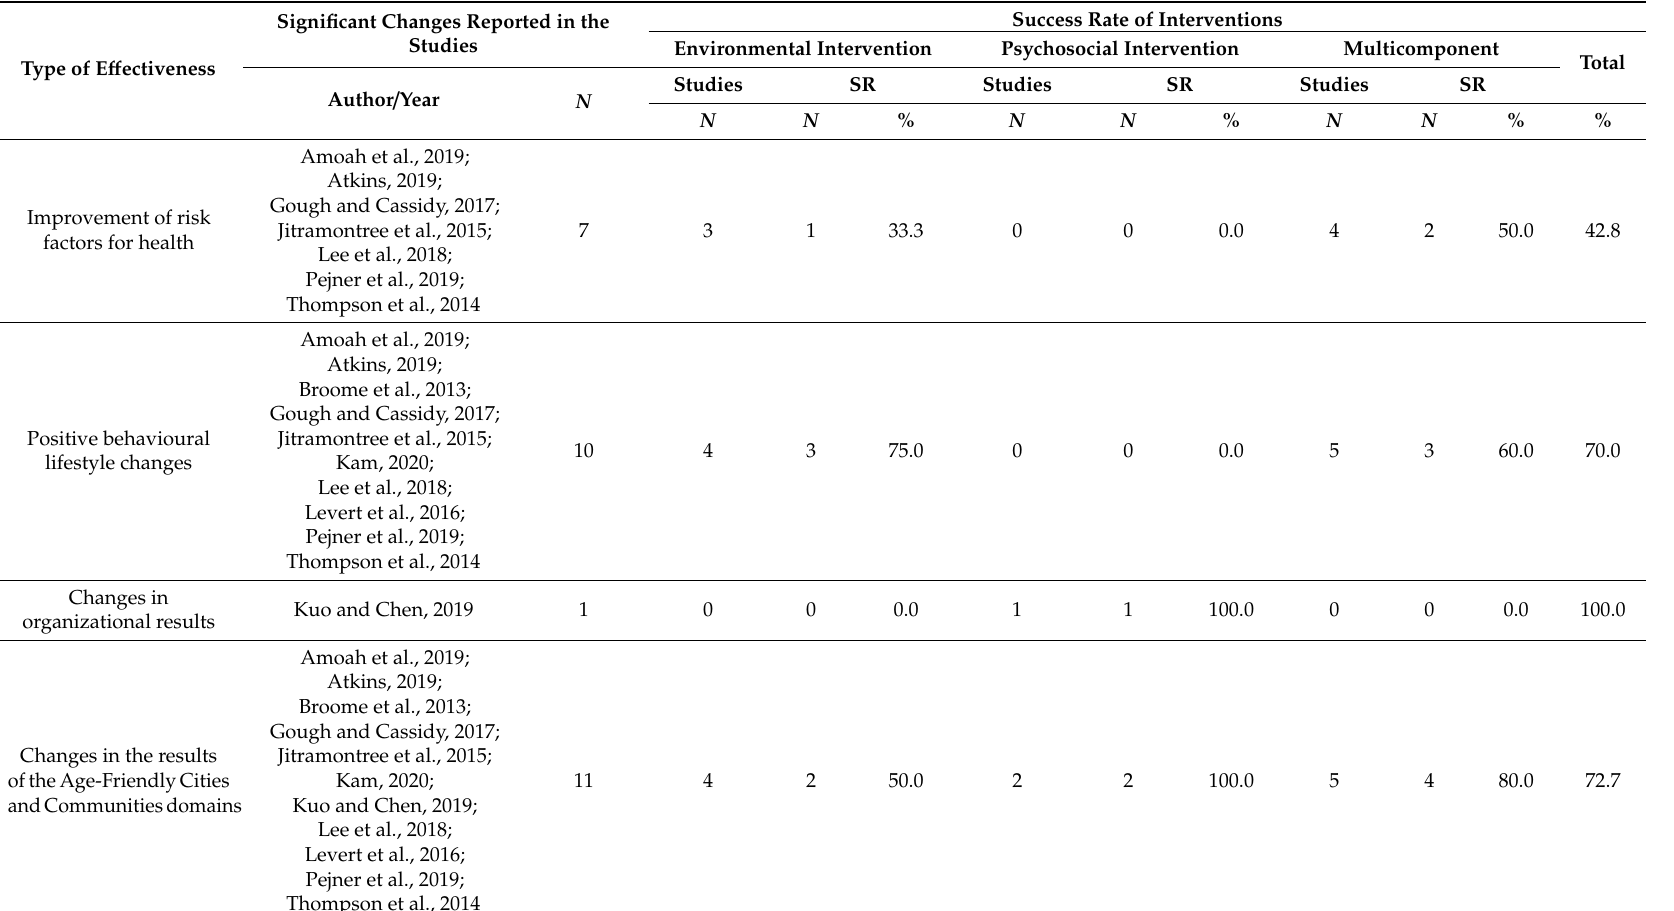
Table 3. E ff ectiveness of interventions in the included